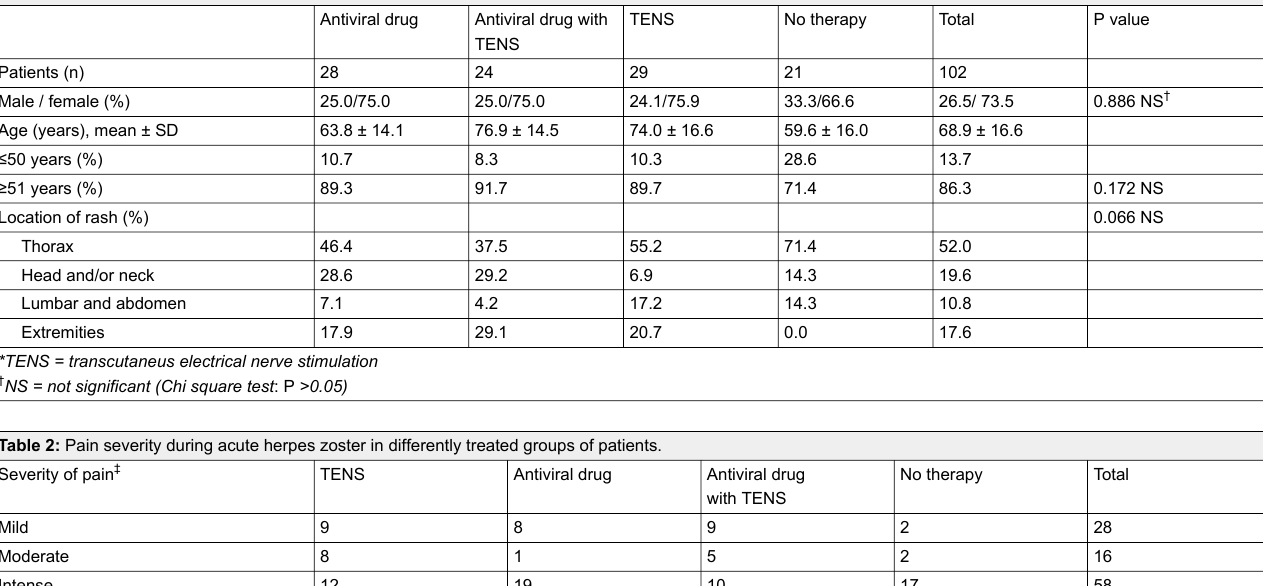
Table 1 : Demographic characteristics of patients with acute Herpes zoster receiving TENS* or antiviral drug alone or antiviral drug with TENS or no therapy.